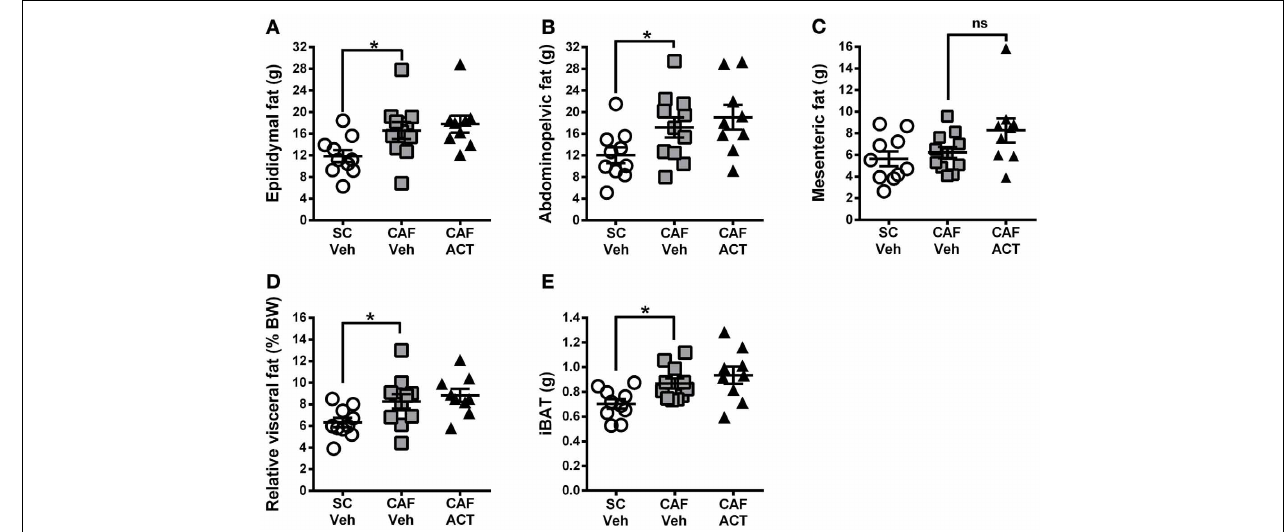
FIGURE 7 | Fat mass at sacrifice. The effect of SC or CAF diet exposure on the mass of epididymal (A) , abdominopelvic (B) , and mesenteric (C) visceral fat deposits in rats treated with Veh or ACT. (D) Normalization of cumulated visceral fat mass (in A–C ) to body weight (BW) per rat and expressed as a